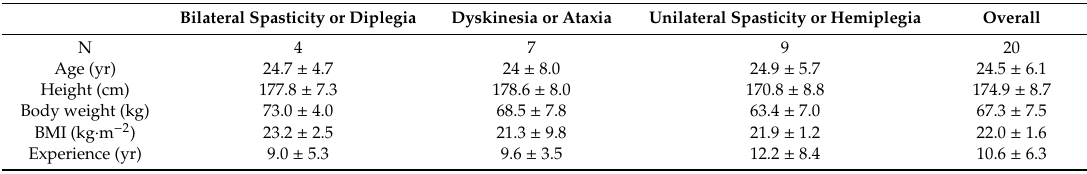
Table 2. Characteristics of the para-athletes with cerebral